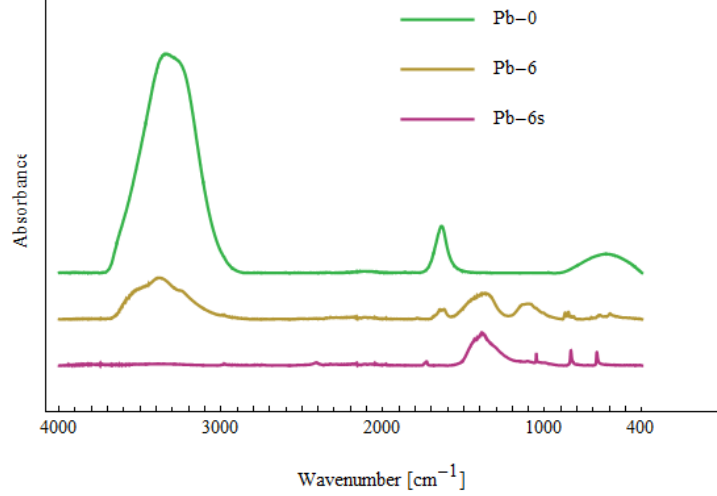
Figure 9. FTIR spectra related to solutions containing Pb(II).